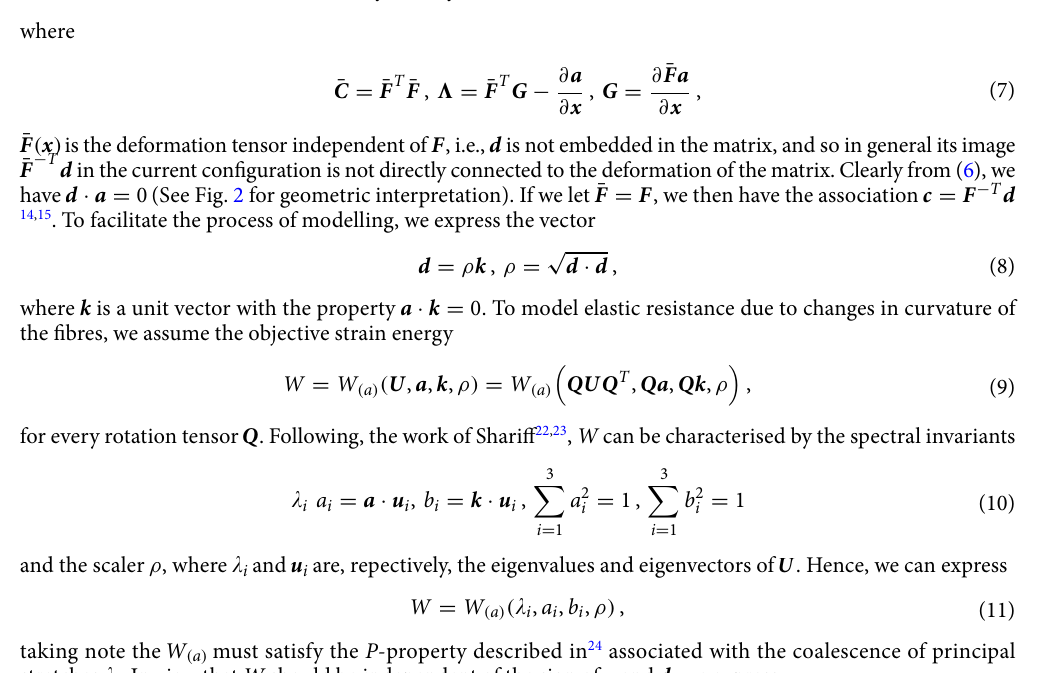
Figure 2. Geometric meaning of directional derivative vectors: F ι b Fa f , and ¯ c = ¯ ¯ = ¯ =